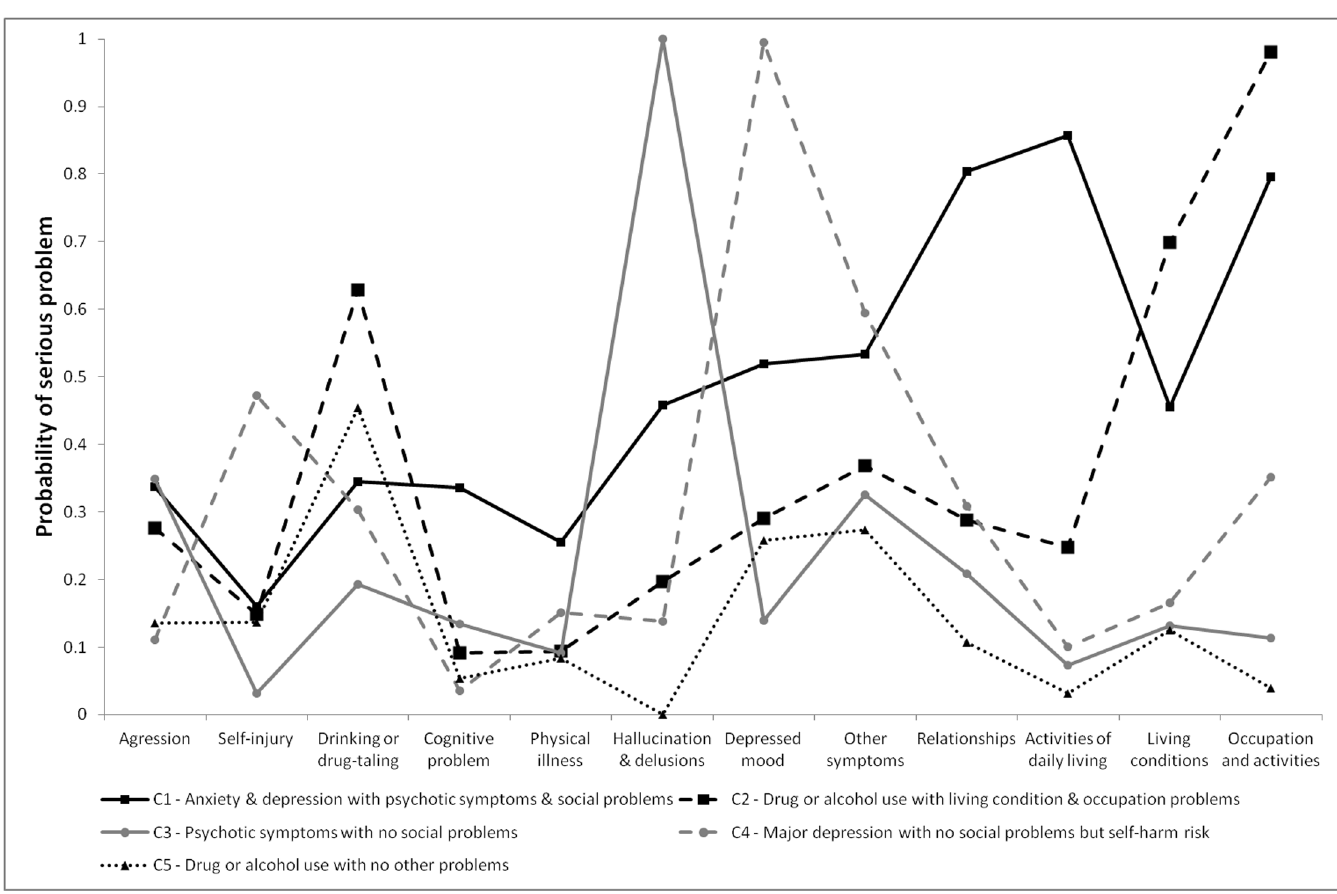
Fig 1. Probability of having serious problem in HoNOS items within five latent